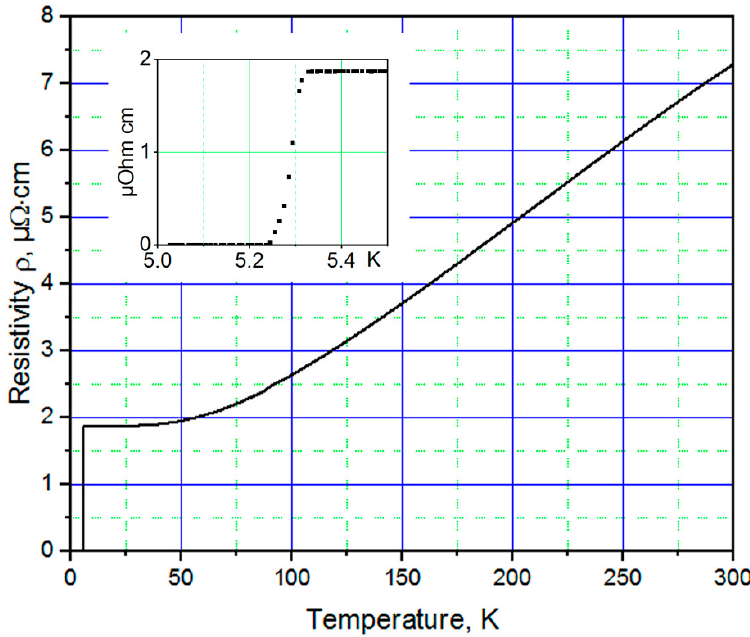
Figure 1. R ( T ) dependence of a 700-nm-thick titanium nitride (TiN) film grown on a Si (100) substrate. The inset shows R(T) dependence at the superconducting transition.